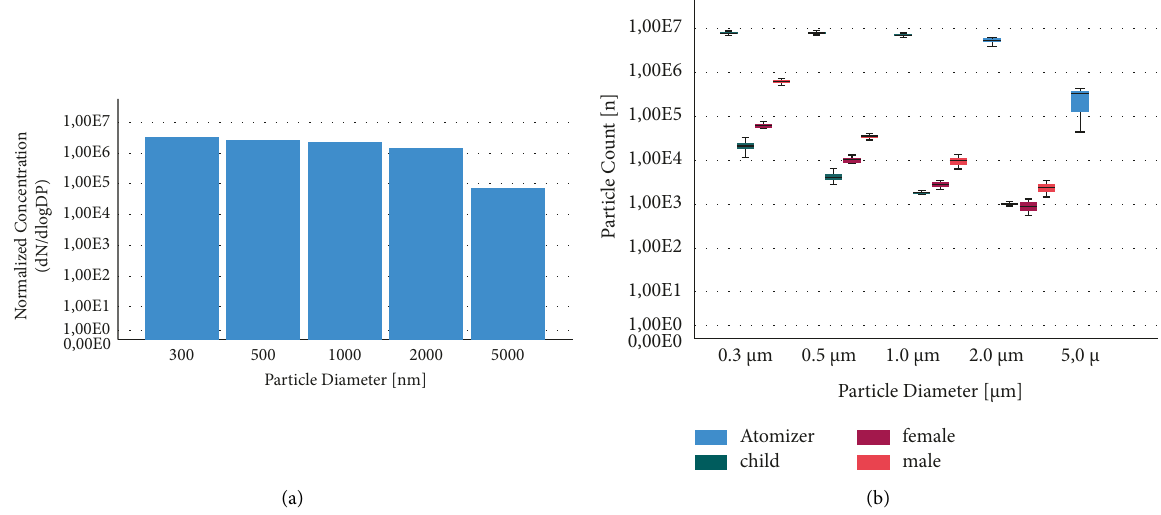
Figure 1: (a) Size distribution of the applicated bioaerosol. (b) Particle count of used aerosol compared to human exhalation